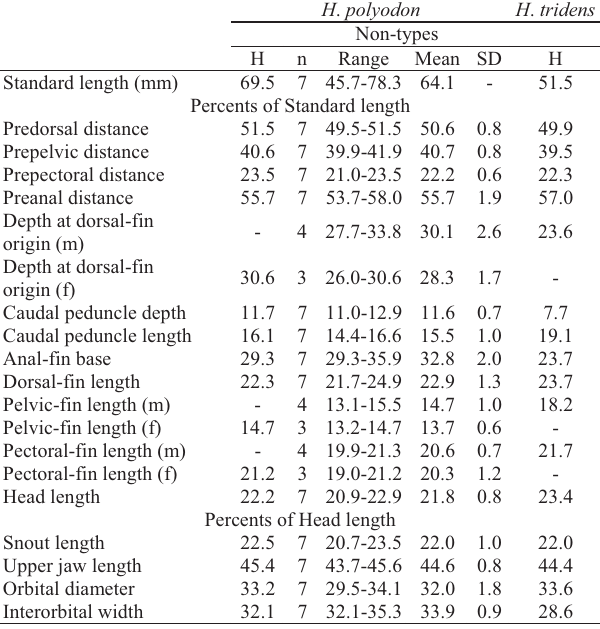
Table 5. Morphometric data of holotype (H) of Hemibrycon polyodon (BMNH 1858.7.25.41) from Guayaquil, Ecuador, and non-types from tributary of río Pastaza, río Marañon basin (KU 19978, 19992, 20004), and of holotype of Hemibrycon tridens (CAS 44358) from rio Apurimac, upper río Ucayali basin, Curuhuasi, Peru. m, males; f, females. SD = Standard